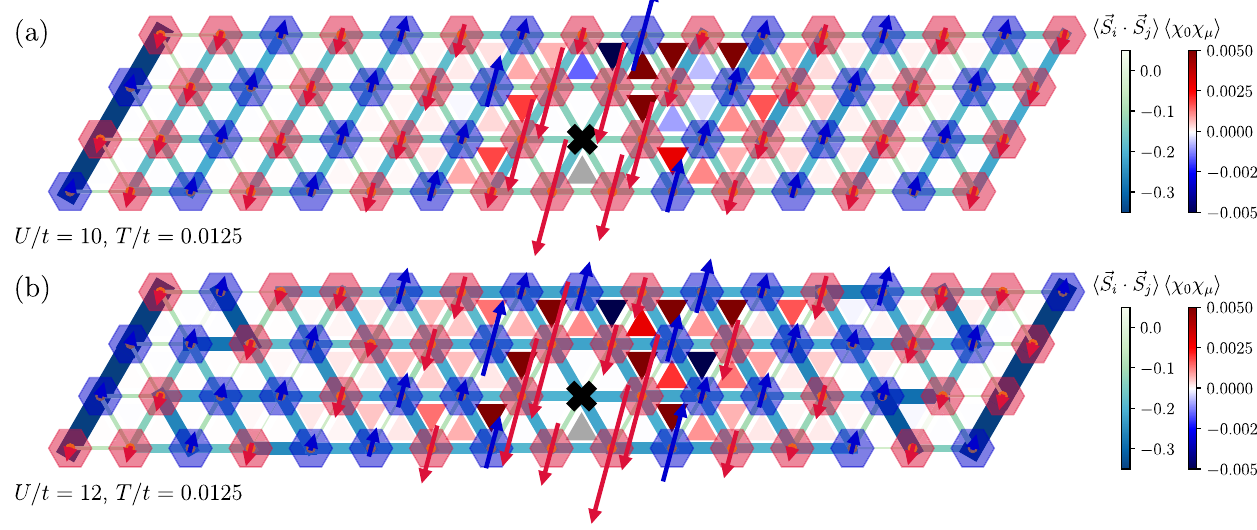
FIG. 7. Snapshots of METTS states j ψ i i at temperature T=t ¼ 0 . 0125 on the 16 × 4 YC4 cylinder in the intermediate regime at U=t ¼ 10 (a) and in the strong coupling regime at U=t ¼ 12 (b). The length of the arrows is proportional to the spin correlation h ⃗ S where the black cross marks the reference site. Hexagons and arrows which are blue indicate positive and red indicate negative spin correlations. The color of the triangles indicates the magnitude of the chiral correlation h χ 0 χ μ i , where the reference triangle is indicated in gray just below the reference site. Nearest-neighbor spin correlations h observe collinear stripy-spin correlations at this temperature in the intermediate regime at U=t ¼ 10